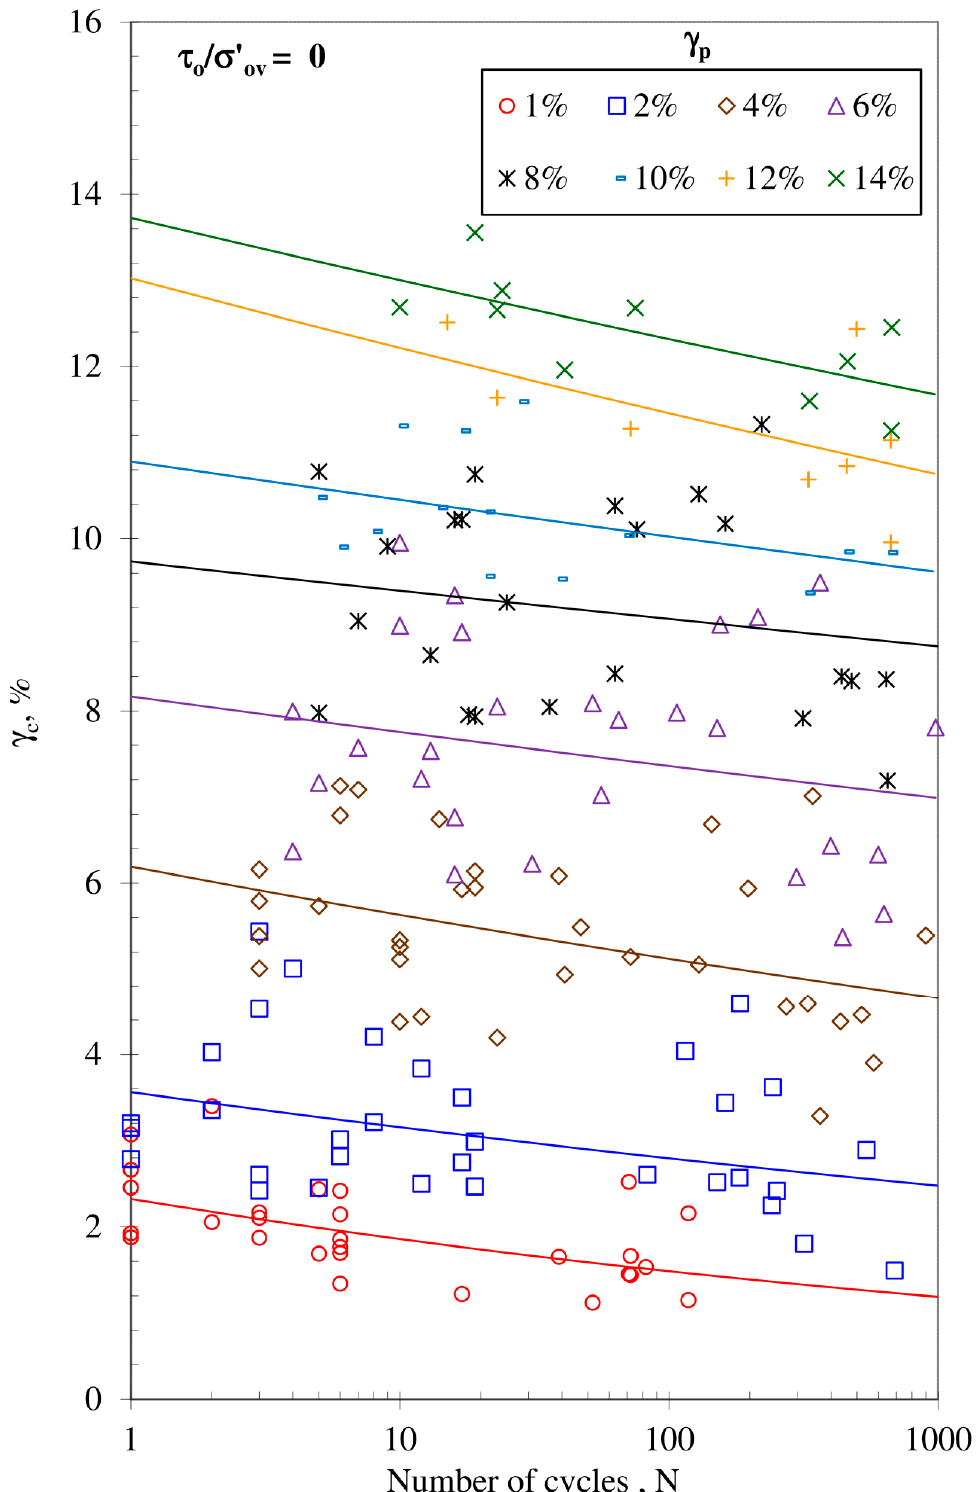
Figure 10. Variation of the cyclic shear strain as a function of the number of cycles and of the permanent shear strain corresponding to τ o / σ′ ov = 0.